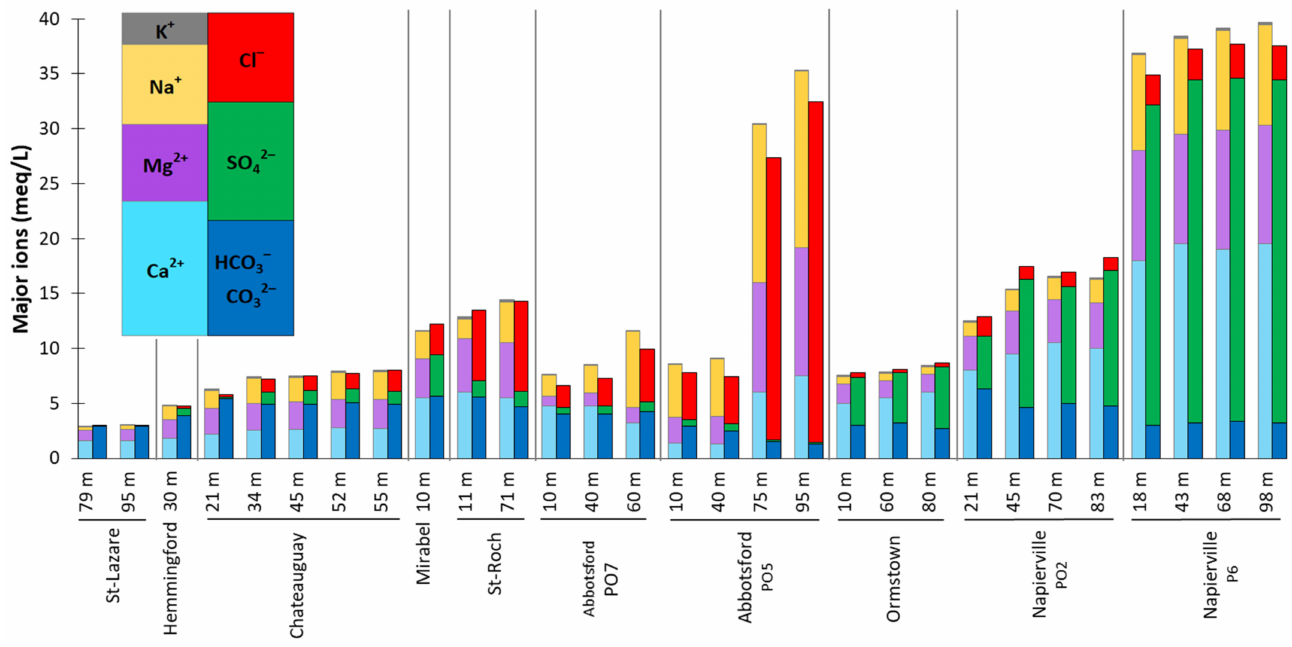
Figure 11. Stabler diagram detailing the major ion composition per wellbore and at